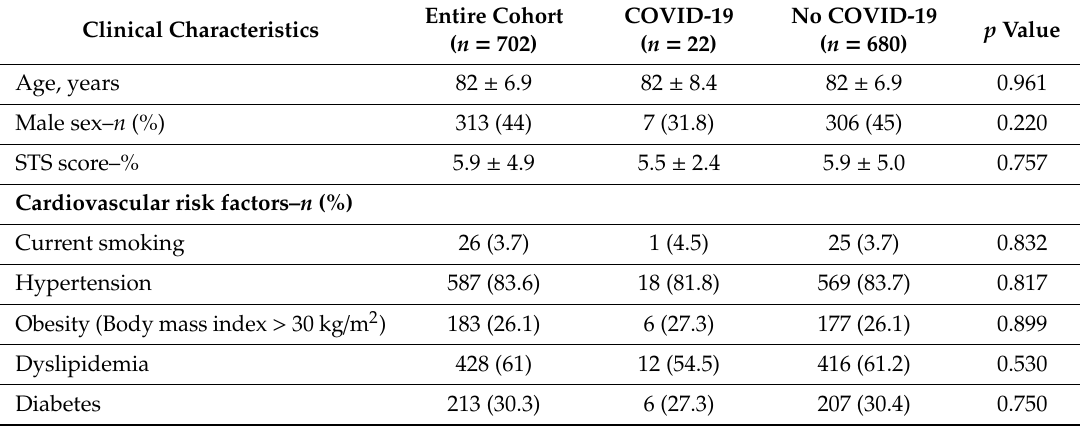
Table 1. General characteristics of patients who had undergone transcatheter aortic valve replacement according to the presence or absence of